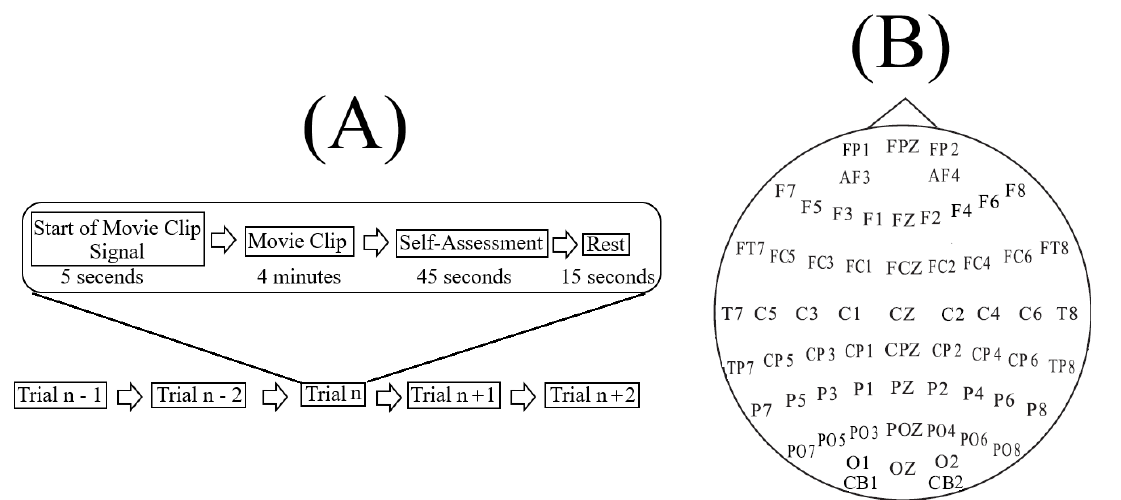
Figure 1. ( A ) Shanghai Jiao Tong University (SJTU) Emotion EEG Dataset (SEED) [49] paradigm. Each setting, per participant, comprised fifteen four-minute movie clips (i.e., n = 15). There was a five-second hint before the start of each clip. After each clip, participants answered (Likert 5-point scale) three questions that assessed their emotion-feeling states [51]. These questions included participants’ actually felt emotion while watching the clip, have they previously watched the fully movie that the clip corresponded to, and how well they comprehended the clip’s content. ( B ) Sixty-two EEG channels’